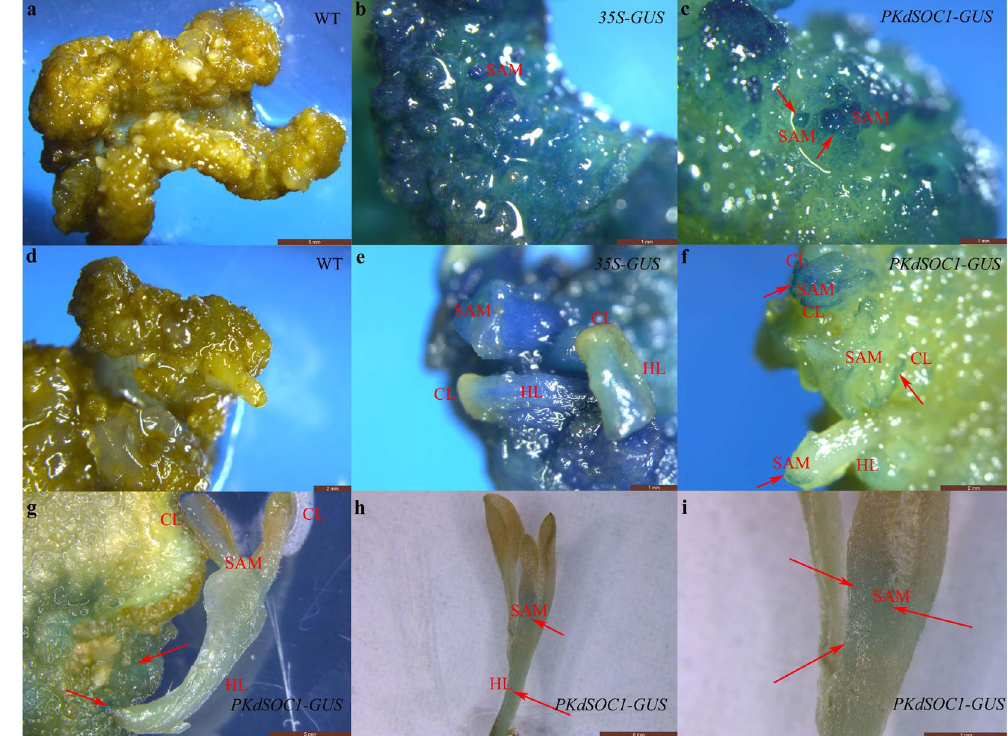
Figure 1. KdSOC1 gene expression profiles during somatic embryogenesis in tobacco callus induction by GUS staining. ( a – c ) Callus of tobacco somatic embryogenesis. ( d–f ) Shooting stage of tobacco somatic embryogenesis. ( g – i ) Mature plantlet regenerated from tobacco callus. Red arrow indicates the GUS staining site of KdSOC1 gene. SAM: shoot apical meristem, CL: cotyledon. HL: